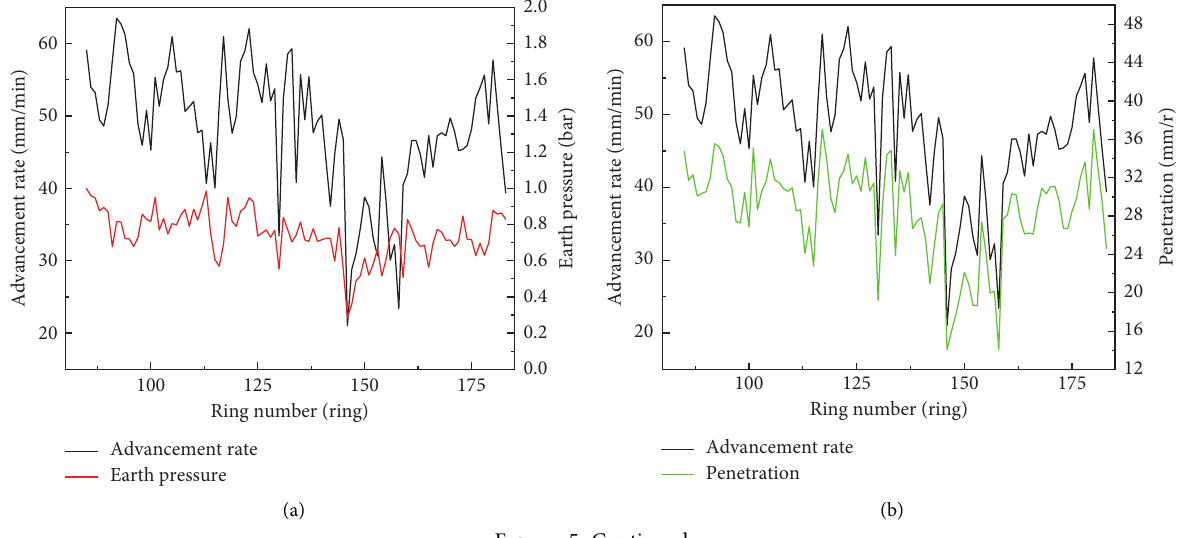
Figure 4: Test section parameter statistics.